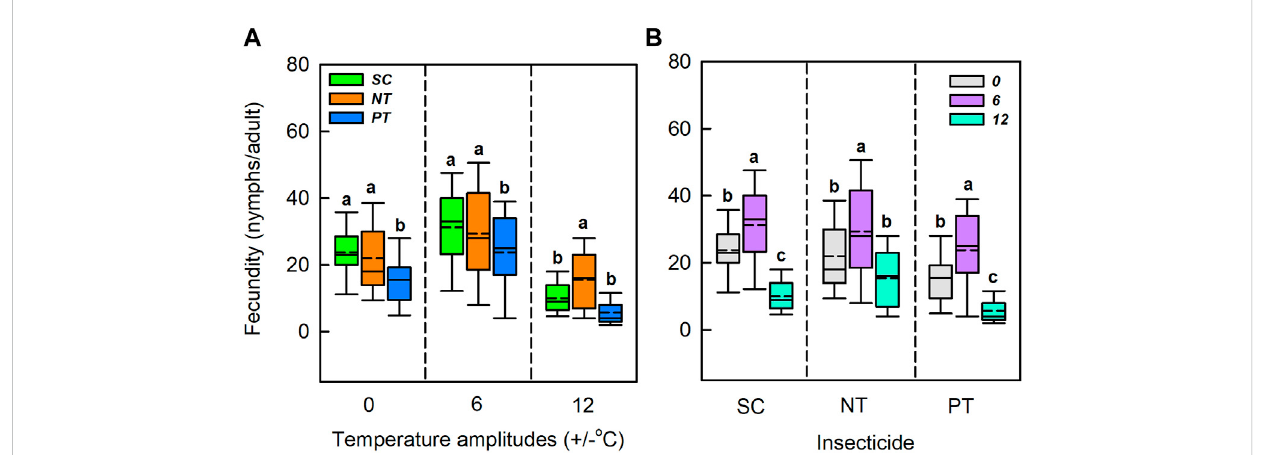
FIGURE 4 Boxplotofthefecundityundervarioustemperatureamplitudes (A) andinsecticides (B) .Theupperandlowerboundariesoftheboxindicatethe75th percentile and 25th percentile of the dataset. The black horizontal line and short dashed-line within the box represent the median and mean values, respectively. Error bars above and below the box indicate the minimum and maximum values, respectively. Different letters above each box indicate signi fi cant differences ( p < 0.05) among the treatments.